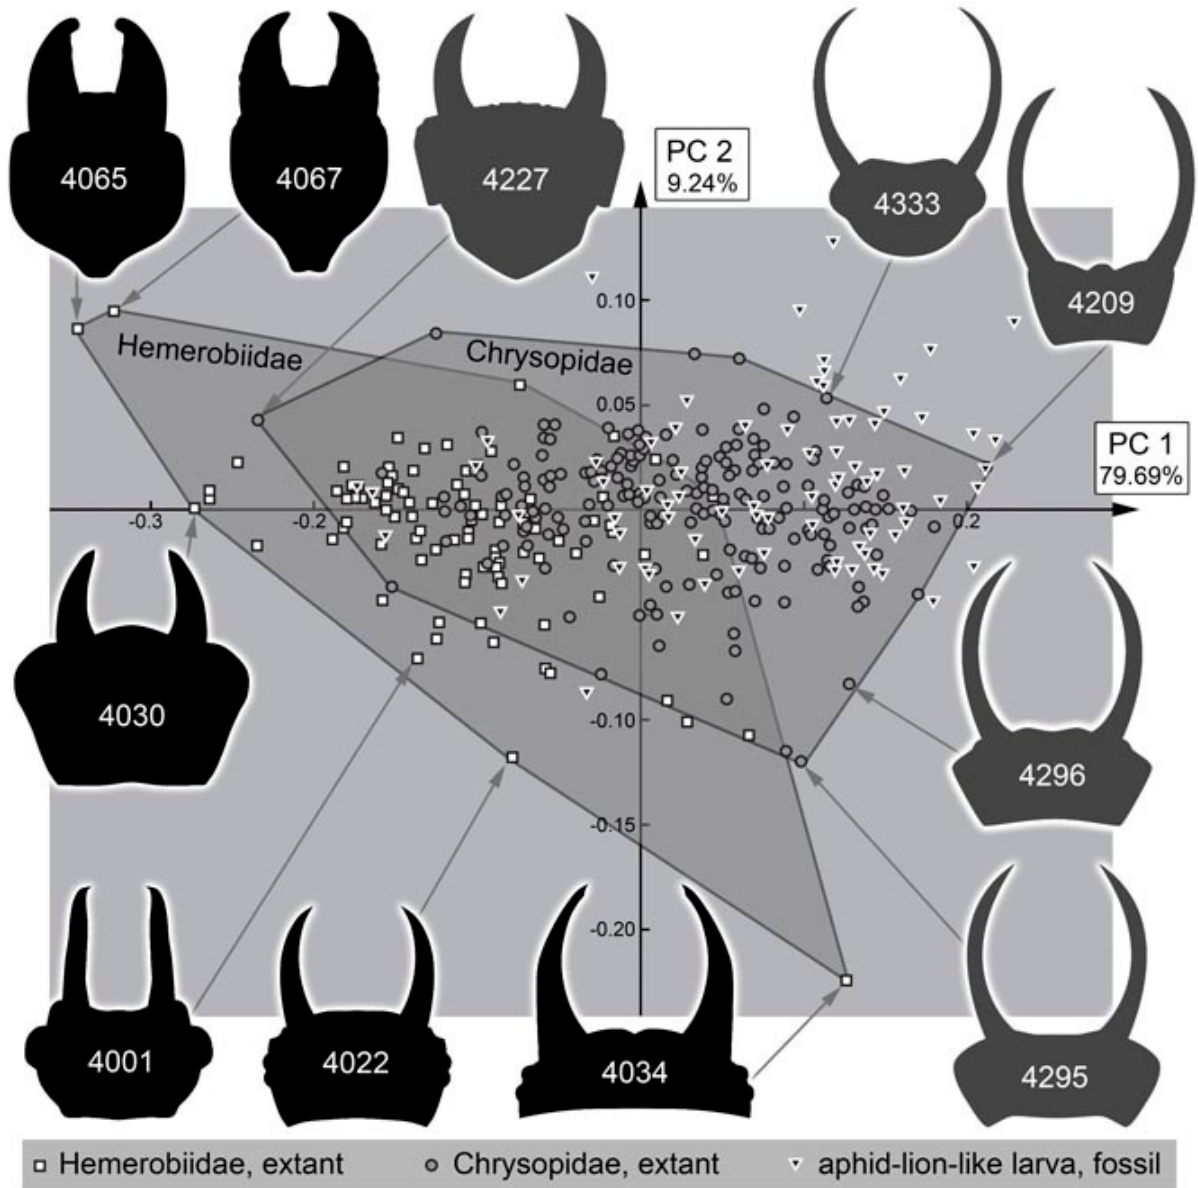
Figure 52. Scatter plot of PC2 vs. PC1 of head shapes of extant and fossil aphidlions and aphidlion- like larvae. Polygons mark areas occupied by extant representatives of Chrysopidae (head shapes exemplified by grey outlines) and Hemerobiidae (head shapes exemplified by black outlines).